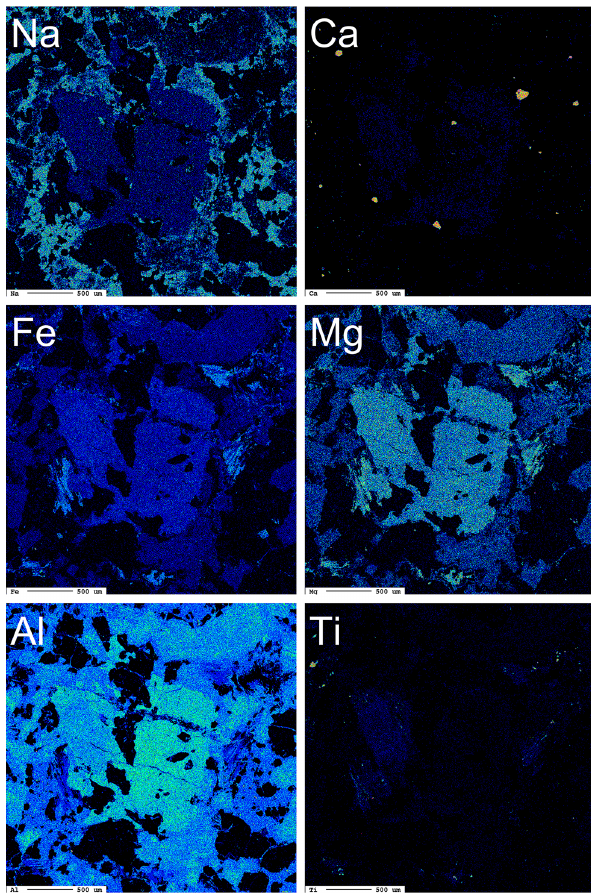
Figure 4. X-ray maps collected on dutrowite and associated oxy- dravite (see Fig.